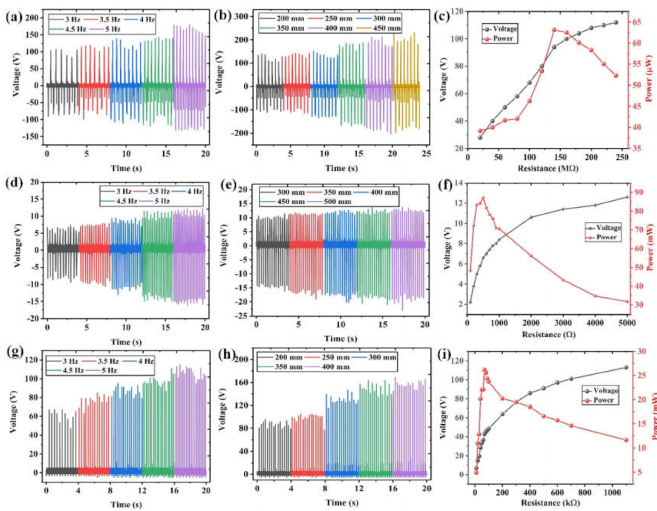
Figure 6. The output voltages of the TENG unit at ( a ) different frequencies and ( b ) different dis- placements, and ( c ) the output voltage and power curve under different external loads. The output voltages of the EMG unit at ( d ) different frequencies and ( e ) different displacements, and ( f ) the output voltage and power curve under different external loads. The output voltages of the PEG unit at ( g ) different frequencies and ( h ) different displacements, and ( i ) the output voltage and power curve under different external